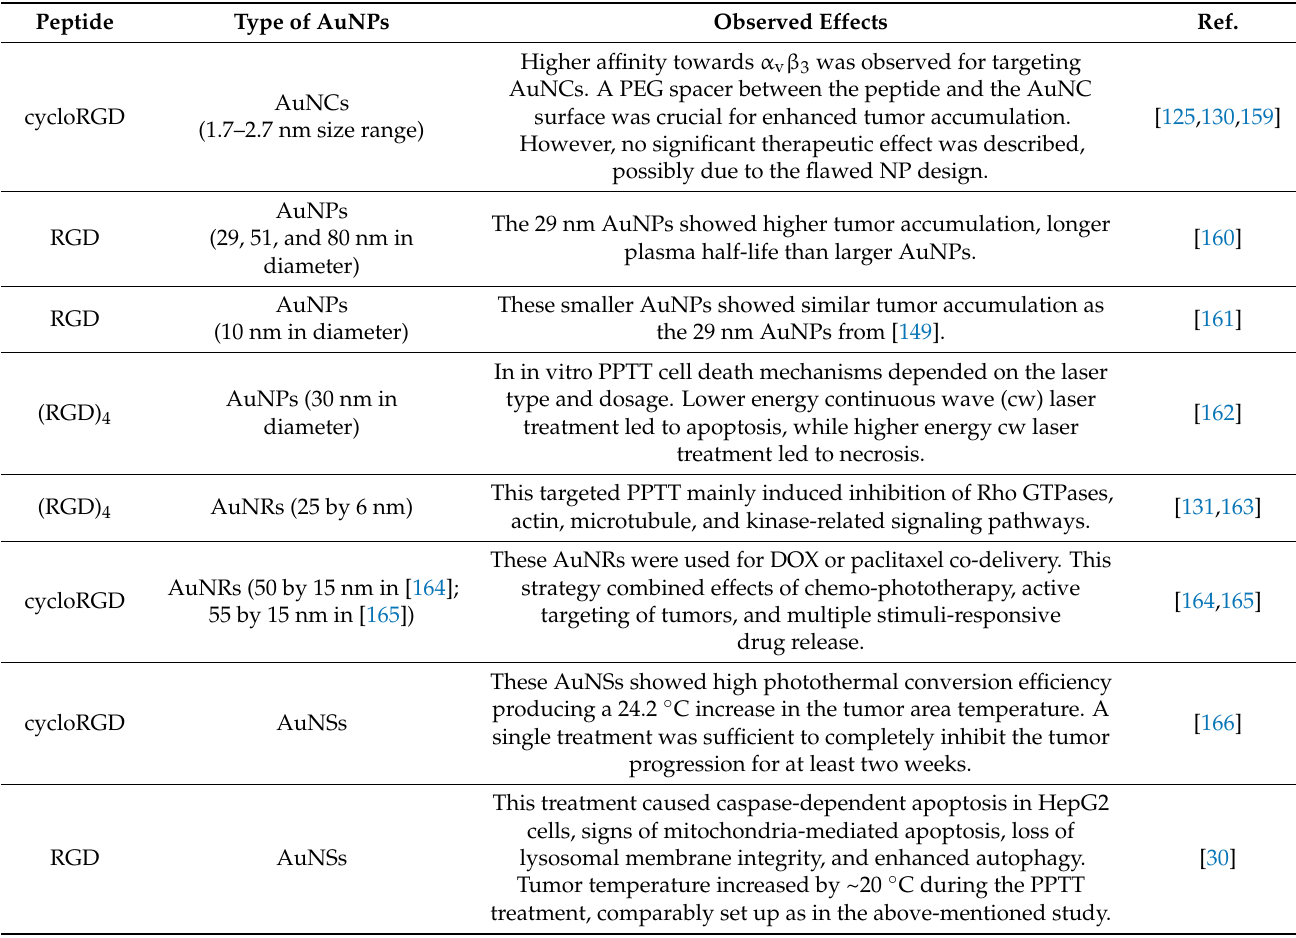
Table 2. Summary of notable examples of integrin-targeting